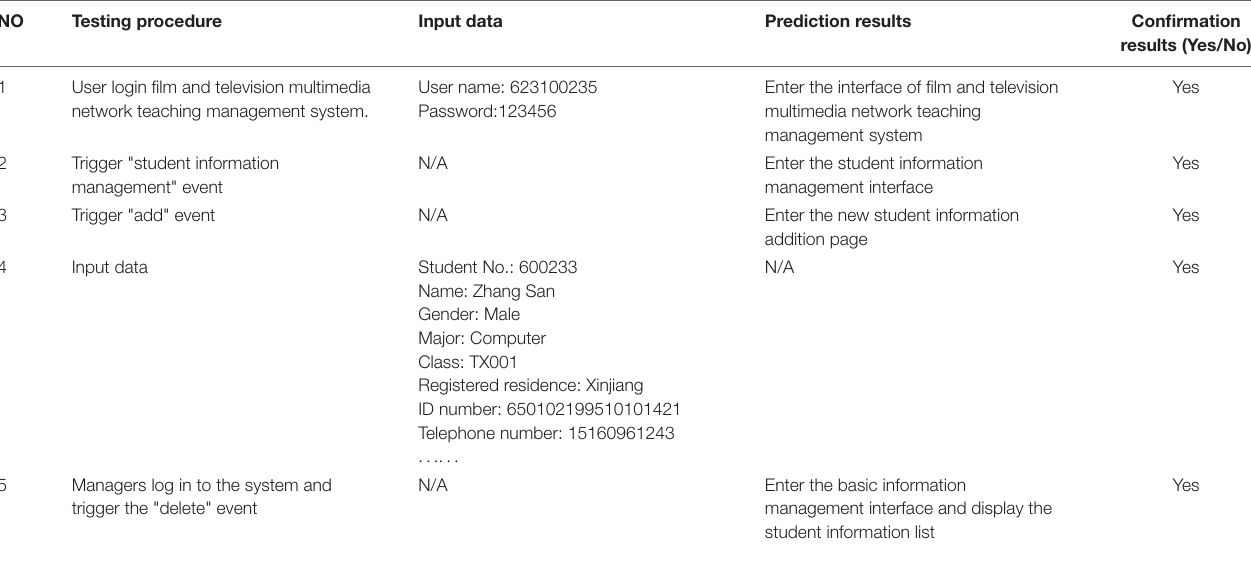
TABLE 5 | Student information management test